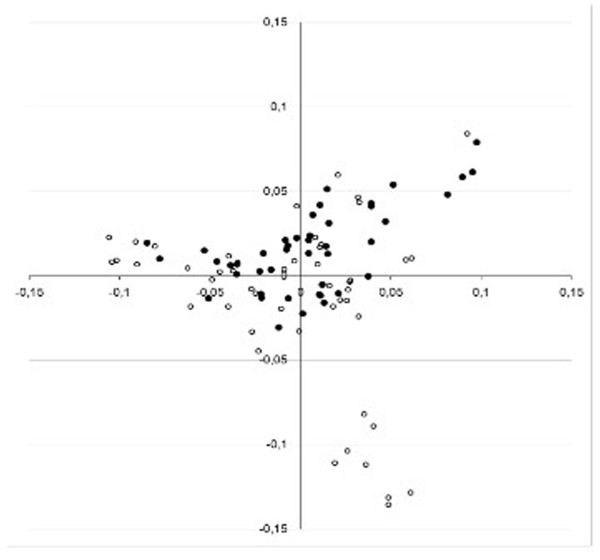
Identical-by-state plot of Flat-Coated Retrievers. The 93 dogs were genotyped using arrays for 22,000 SNPs. The first two principal components of a multidimensional identical-by-state matrix of 45 dogs with patellar luxation (filled symbols) and 48 control dogs that were negative for patellar luxation (open symbols) were calculated with PLINK software. The cluster of 8 controls at the bottom right part of the plot was excluded from further analysis.